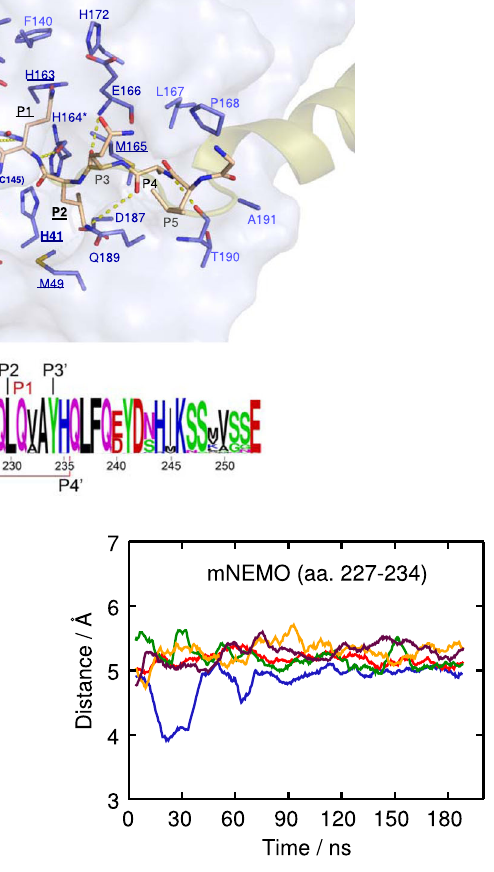
the binding site is shown as solid and transparent surfaces, respectively. b Sequence Logo generated with WebLogo 74 of NEMO (aa. 216-253) across 535 animalsequences,includingthosefromplacentals,bats,marsupials,birds,rodents, andprimates.ClustalOmega 75 wasusedforthemultiplesequencealignmentandas an input for the WebLogo analysis. c Time evolution of the distance between the catalytic S − in 3CLpro Cys145 and the carbonyl C of Gln231 in hNEMO 227 – 234 and mNEMO 227 – 234 computed from MD